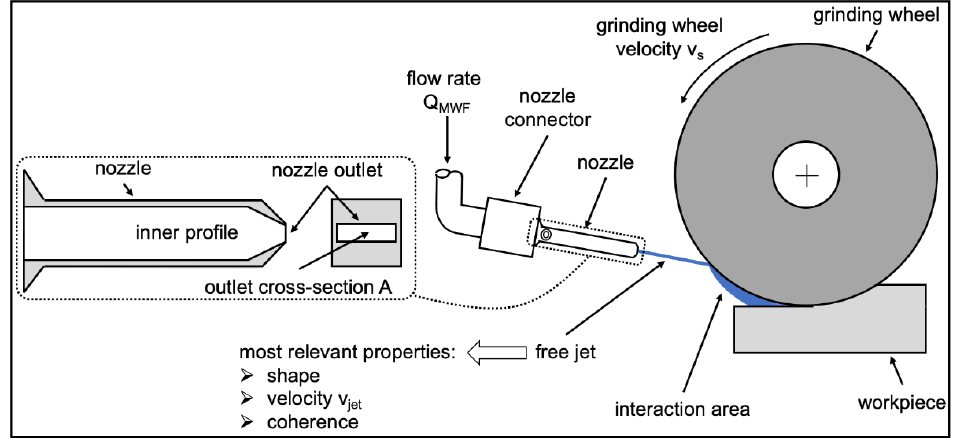
Figure 1. MWF supply during grinding.